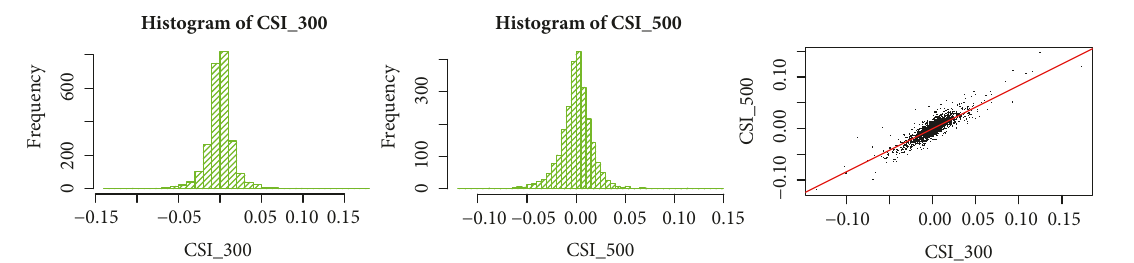
Figure 1: Histograms and scatter plot of CSI 300 and CSI Smallcap